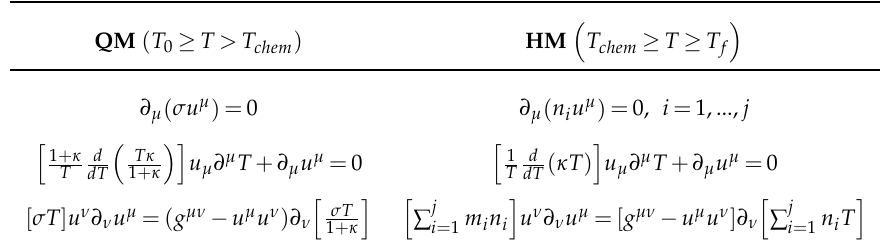
The closed system of partial differential equations, corresponding to relativistic hydrodynamics, as specified for quark matter (QM) and for a chemically frozen, multi-component hadronic matter (HM). Utilizing the equations of state from Table 1, we obtain five equations for five unknowns in the high temperature, QM phase, while we obtain j + 4 equations for j + 4 unknowns in the chemically frozen, multi-component HM phase, where j counts the number of type of chemically frozen